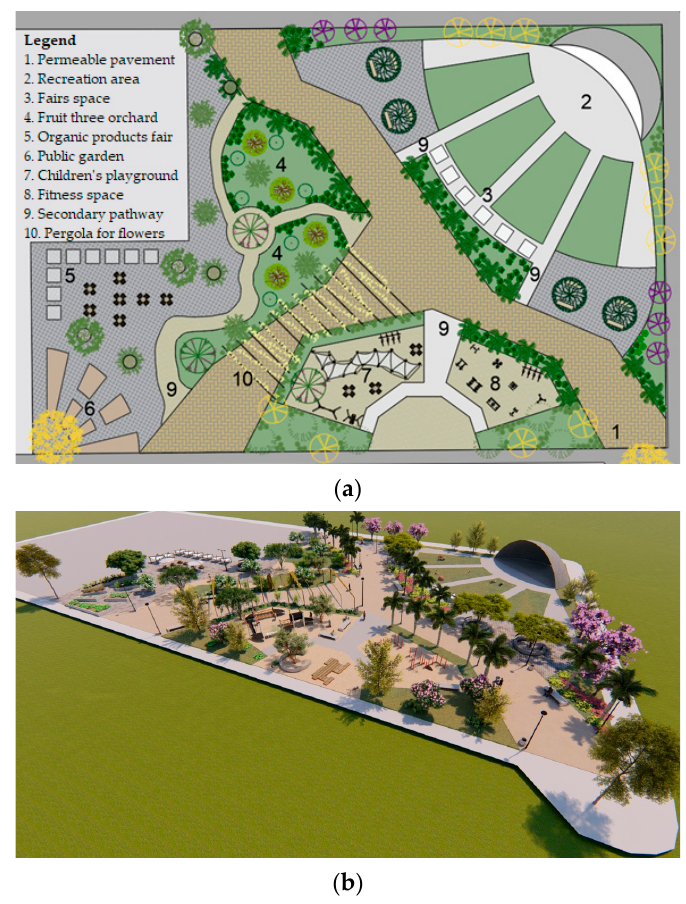
Figure 7. Public square design. ( a ) Plan view (scale: 1:1000). ( b ) 3D view.